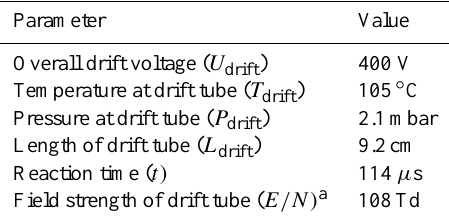
Table 2. Pricipal parameters for PTR-MS operation.